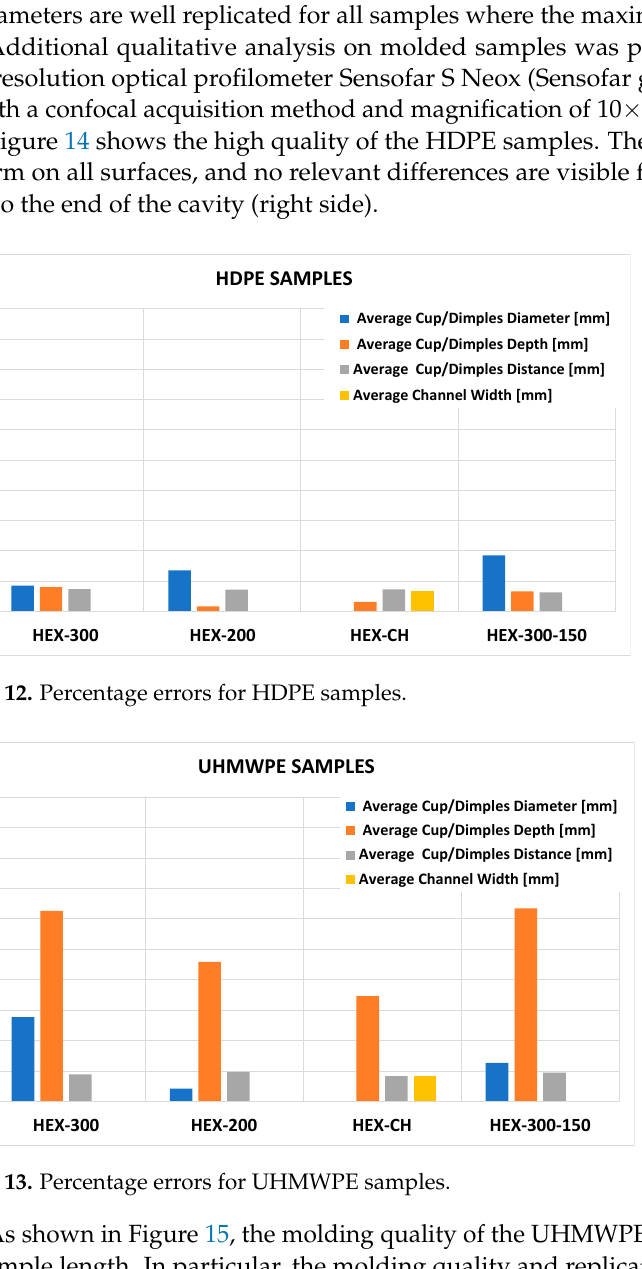
Figure 14. Isometric 3D view of the molded HDPE samples: HEX-300 ( a ); HEX-200 ( b ); HEX-300- 150 ( c ); HEX-300+CH ( d ).